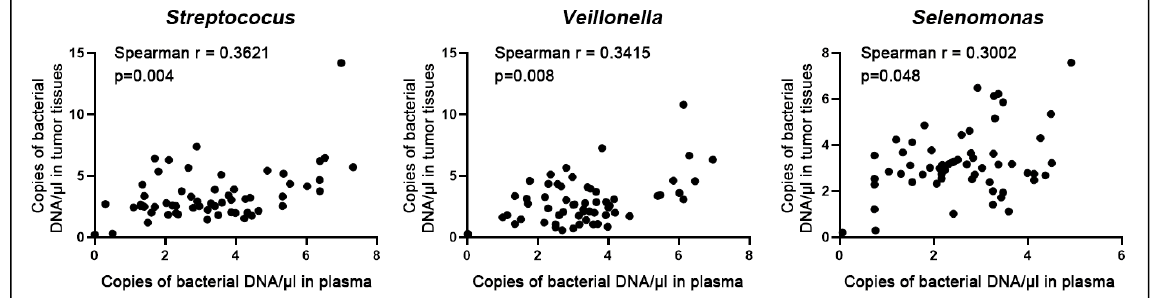
Figure 4. Correlation of the bacterial abundances in cancer specimens and the corresponding plasma of patients with NSCLC. Combined scatter plots show a significant correlation in DNA copy numbers of three bacterial genera ( Selenomonas , Streptococus , and Veillonella ) between lung tumor tissues and plasma samples (All p < 0.05; Spearman’s rank correlation).